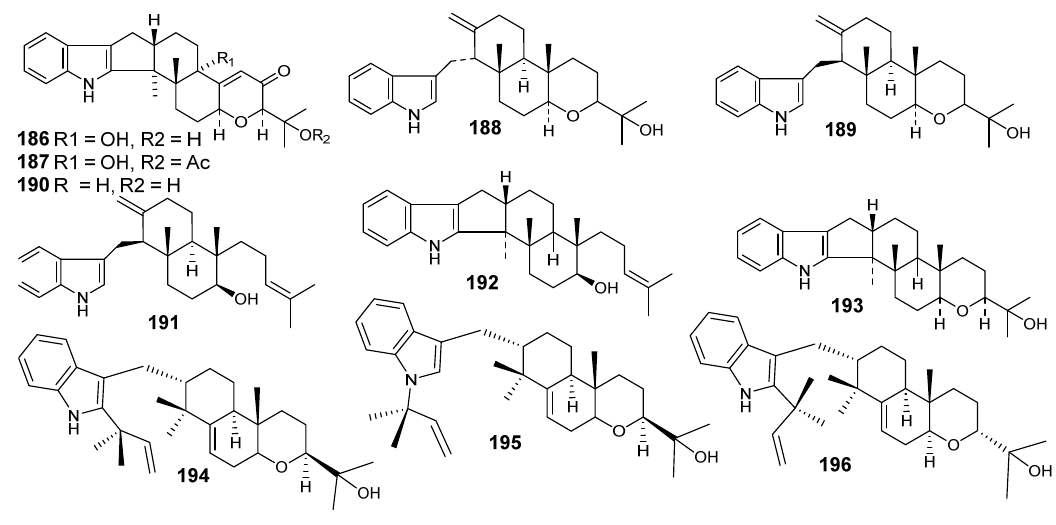
Figure 12. Structures of compounds 186–196.